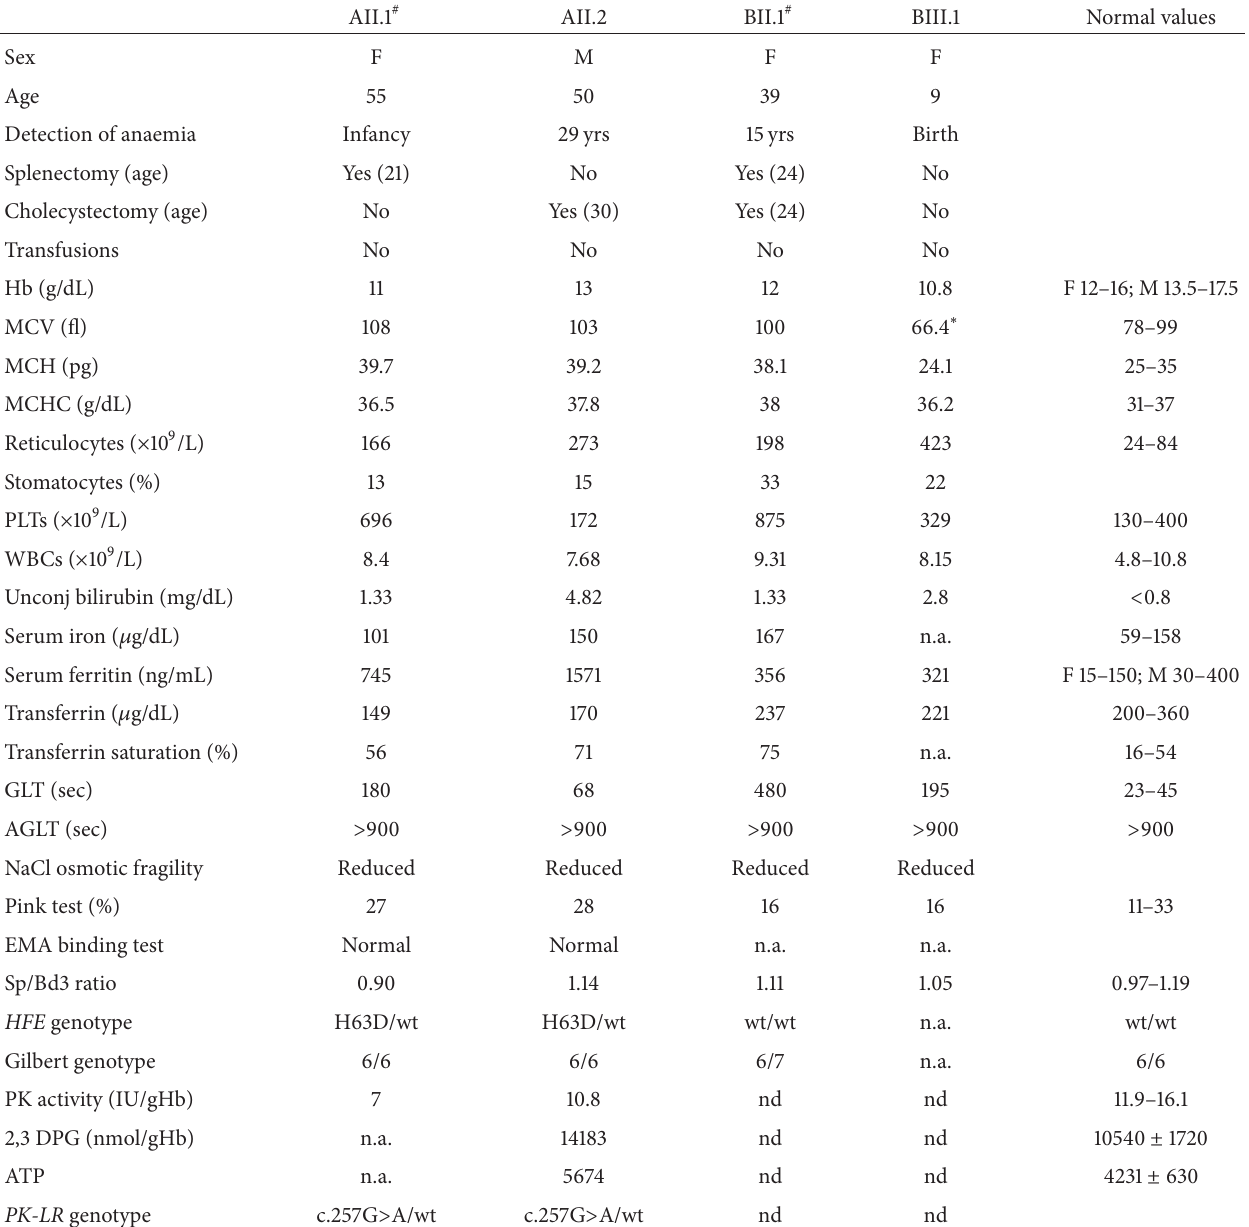
Table 1: Clinical and haematological data of the patients at the time of the